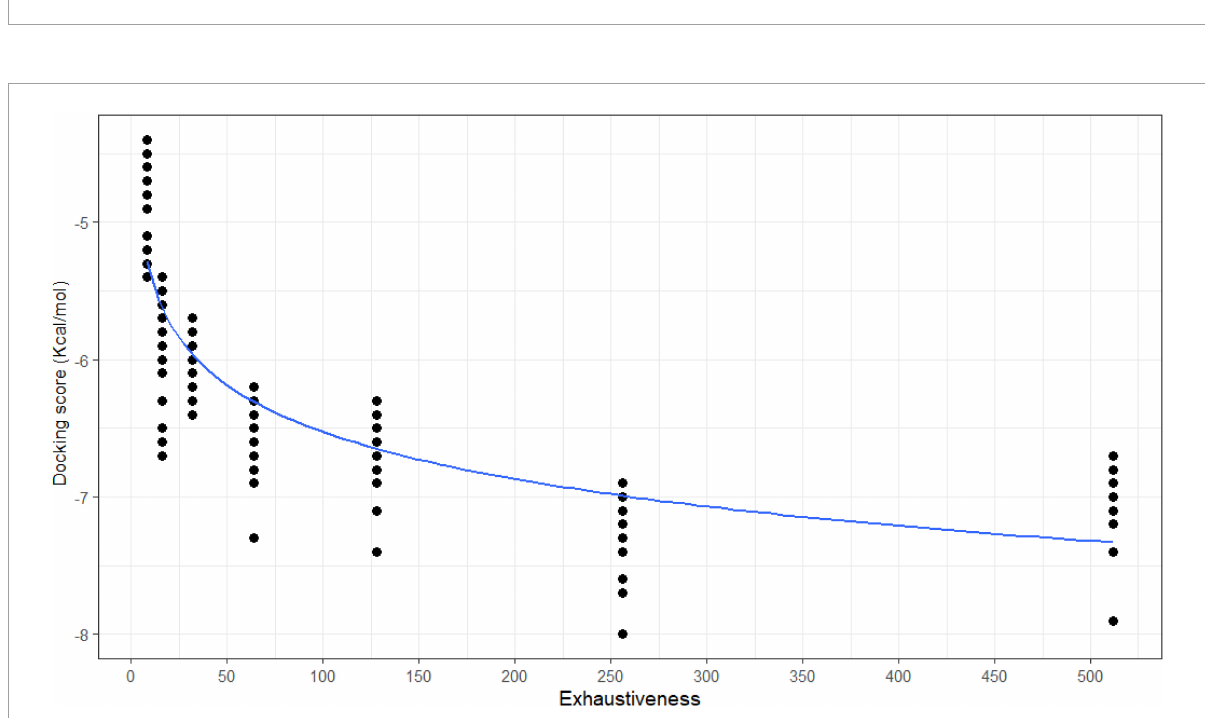
FIGURE1 Clustering of models generated from the exhaustiveness optimization between ligand Rupintrivir and 3C pro protein of 5C1U (PDB ID) with value (A) 8 (default), (B) 16, (C) 32, (D) 64, (E) 128, (F) 256, and (G) 512. The figure was illustrated by Python-based Molecular View with ribbon-shaped proteins and atom-shaped ligands.